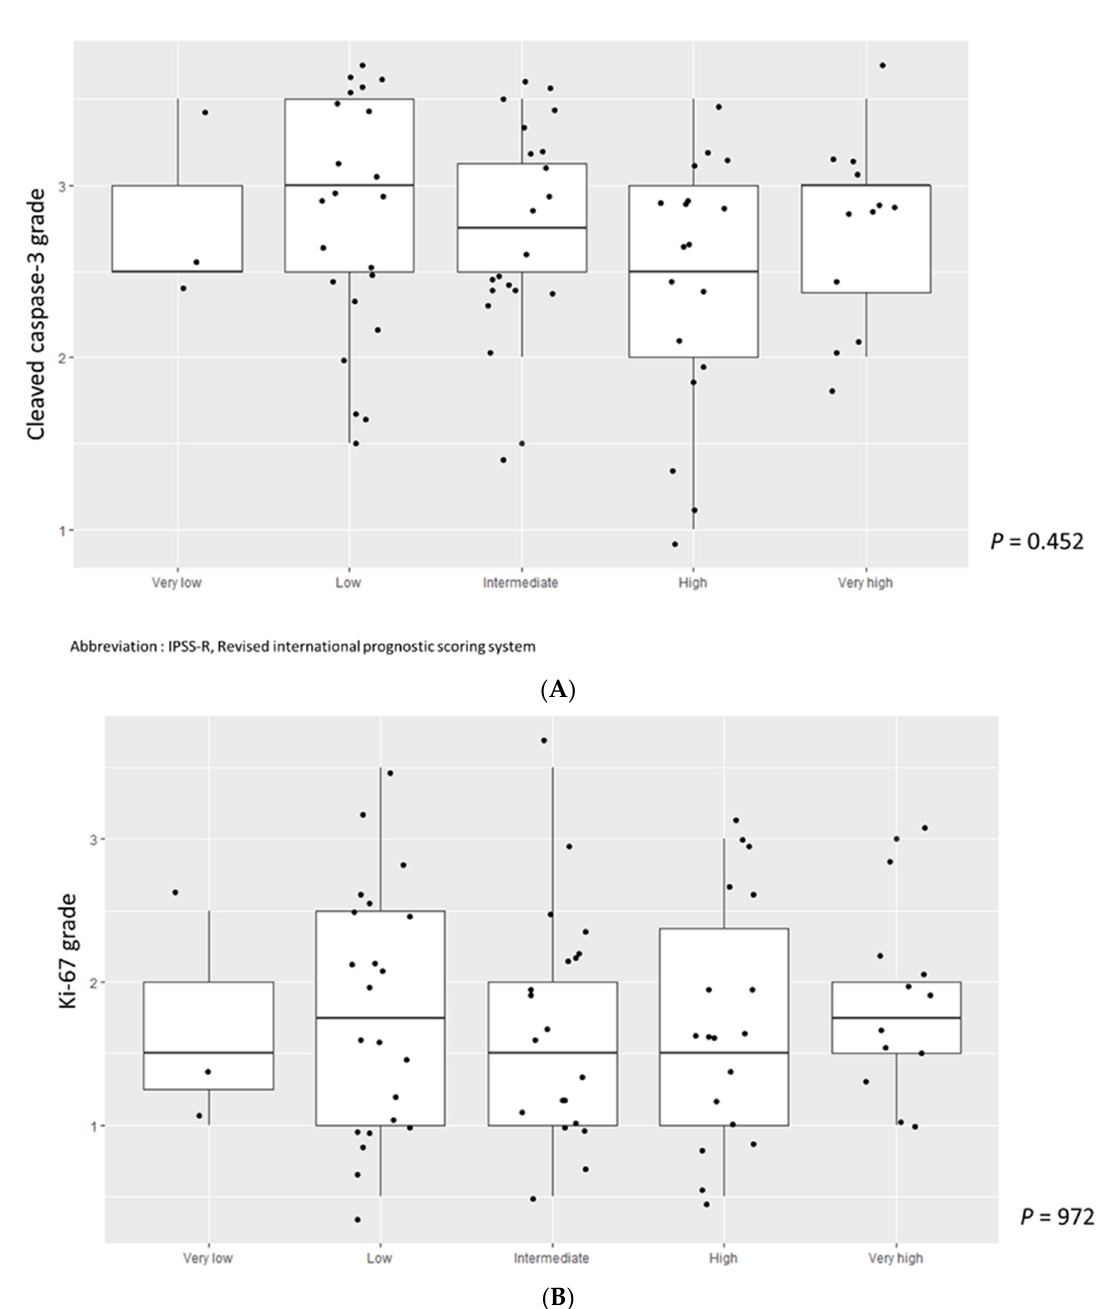
Figure 4. ( A ) Cleaved caspase-3 grade according to IPSS-R risk stratification. Abbreviation: IPSS-R, Revised international prognostic scoring system; ( B ) Ki-67 grade according to IPSS risk stratifica- Revised international prognostic scoring system. ( B ) Ki-67 grade according to IPSS risk stratification. tion. Abbreviation: IPSS-R, Revised international prognostic scoring system;. Abbreviation: IPSS-R, Revised international prognostic scoring